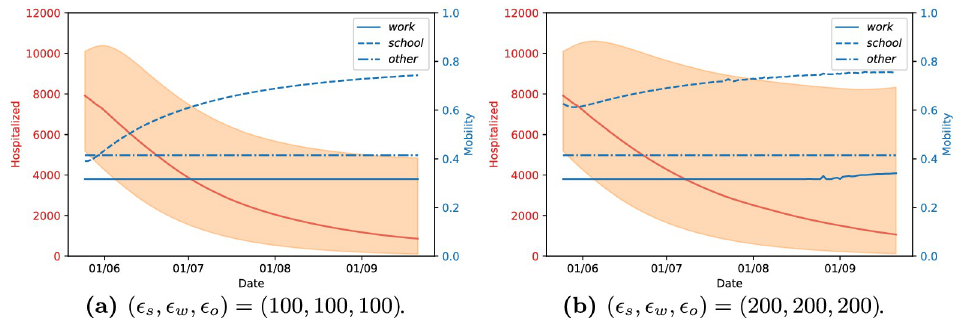
Fig 8. Different relative weights between the sanitary cost and economic cost of the lockdown measures with the lockdown strategies starting on the 24th of May and applied for T